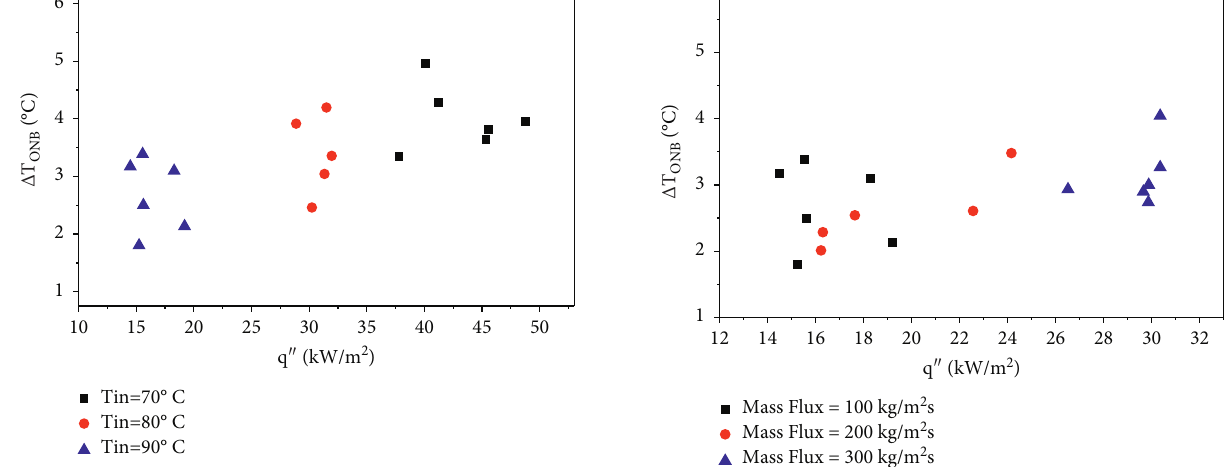
Figure 12: Effect of mass flux on Δ T